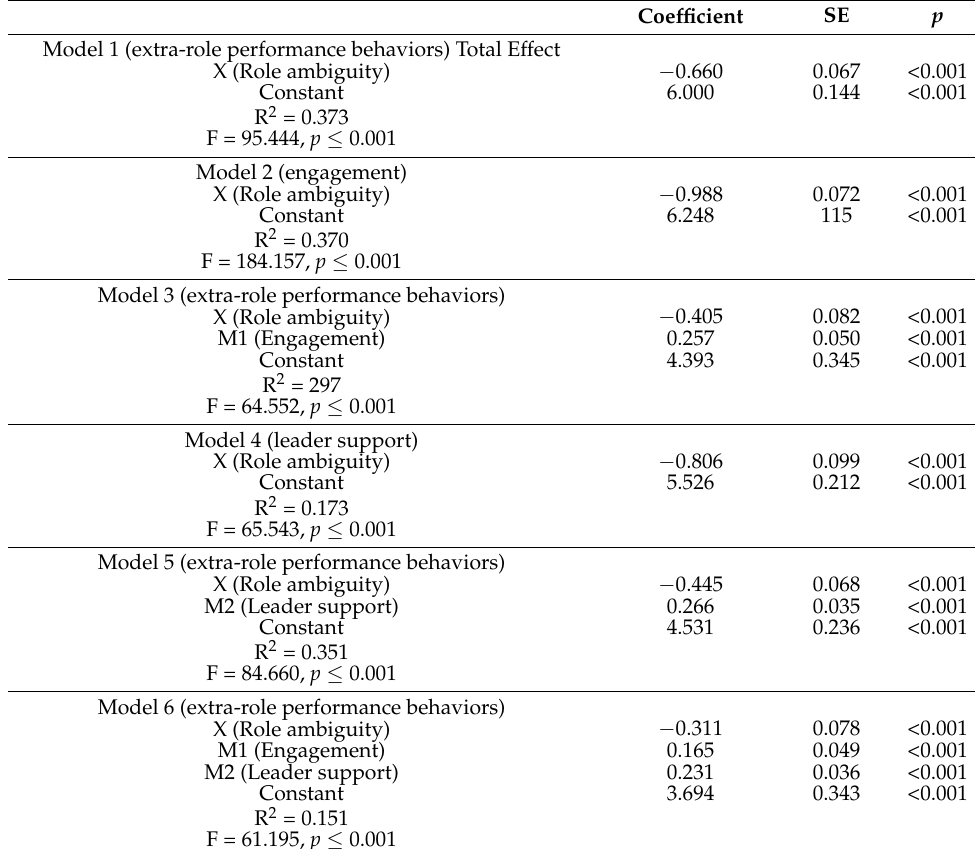
Table 3. Results from the regression analyses examining the mediator model of the effect of role ambiguity (x) on extra-role performance behavior (y) through leader support (m1) and engagement. Coefficient SE p Model 1 (extra-role performance behaviors) Total Effect X (Role ambiguity) − 0.660 0.067 <0.001 Constant 6.000 0.144 <0.001 R 2 = 0.373 F = 95.444, p ≤ 0.001 Model 2 (engagement) X (Role ambiguity) − 0.988 0.072 <0.001 Constant R 2 = 0.370 F = 184.157, p ≤ 0.001